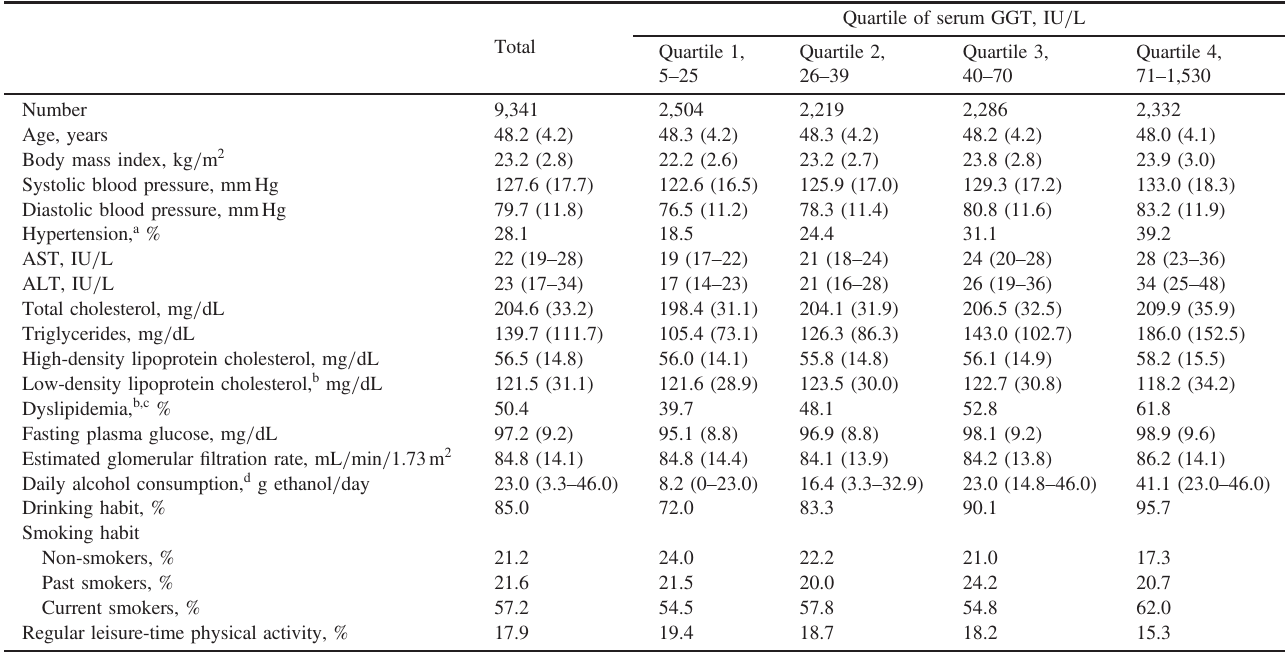
Table 1. Baseline characteristics of study participants for incident persistent proteinuria according to quartile of baseline serum